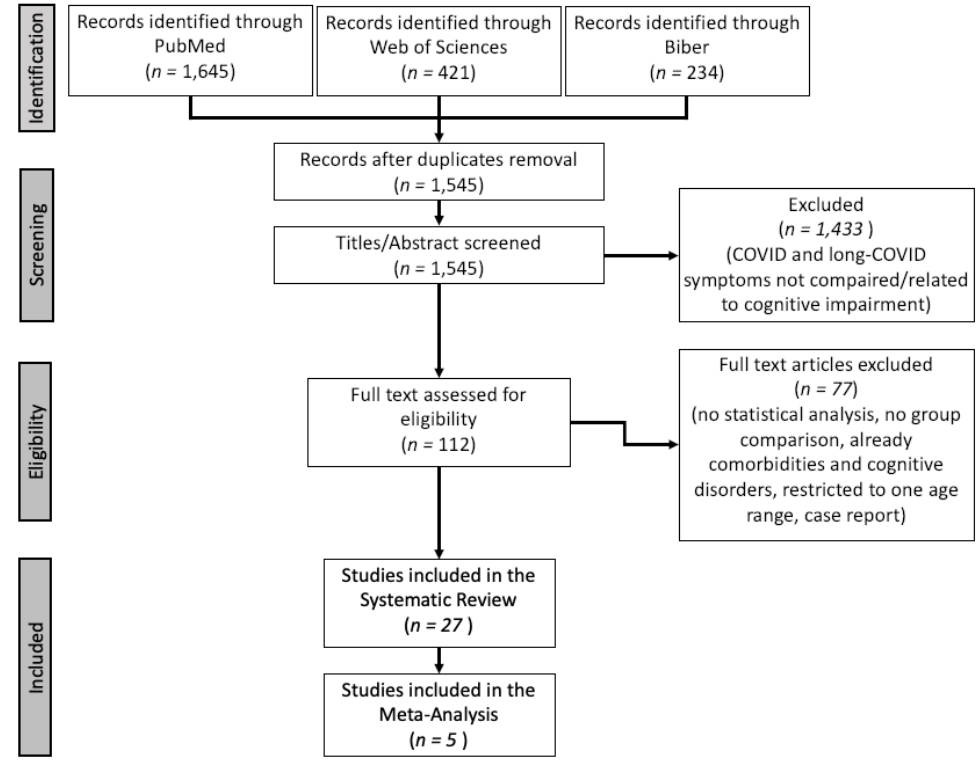
Figure 1. Flowchart of study selection.